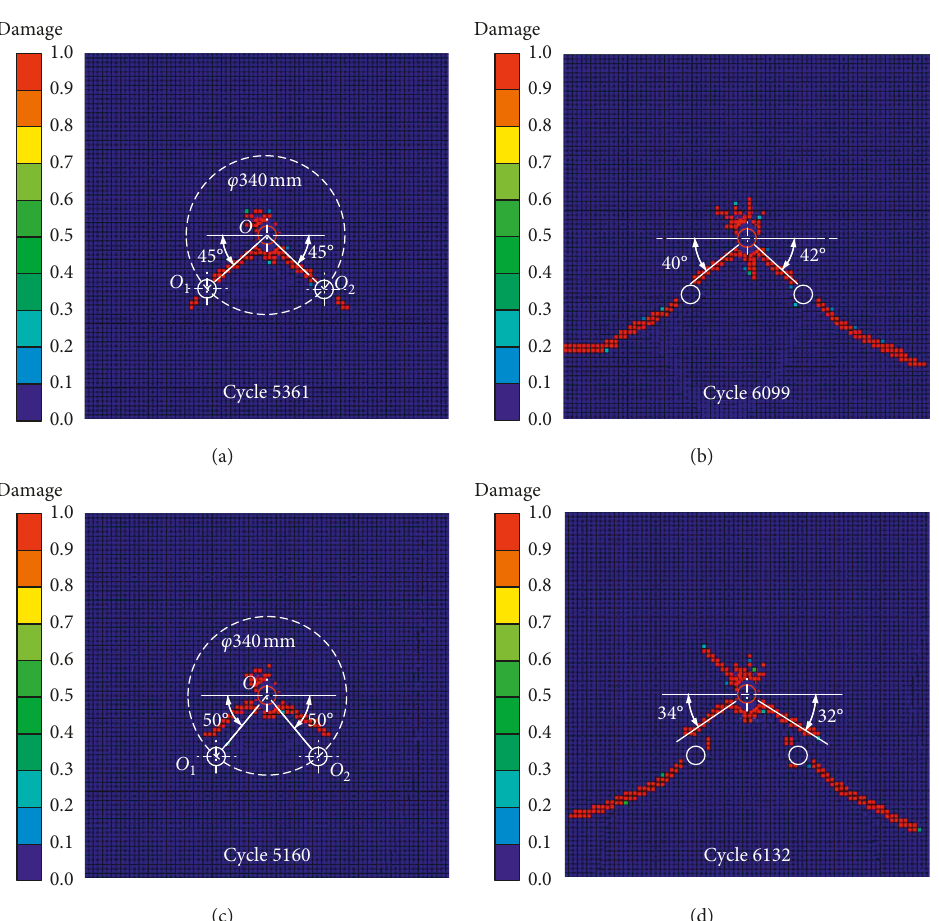
Figure 15: Dynamic rock-breaking process induced by a hydraulic splitter with different α : α � 45 ° (a) at cycle 5361 and (b) at cycle 6099; α � 50 ° (c) at cycle 5160 and (d) at cycle 6132.